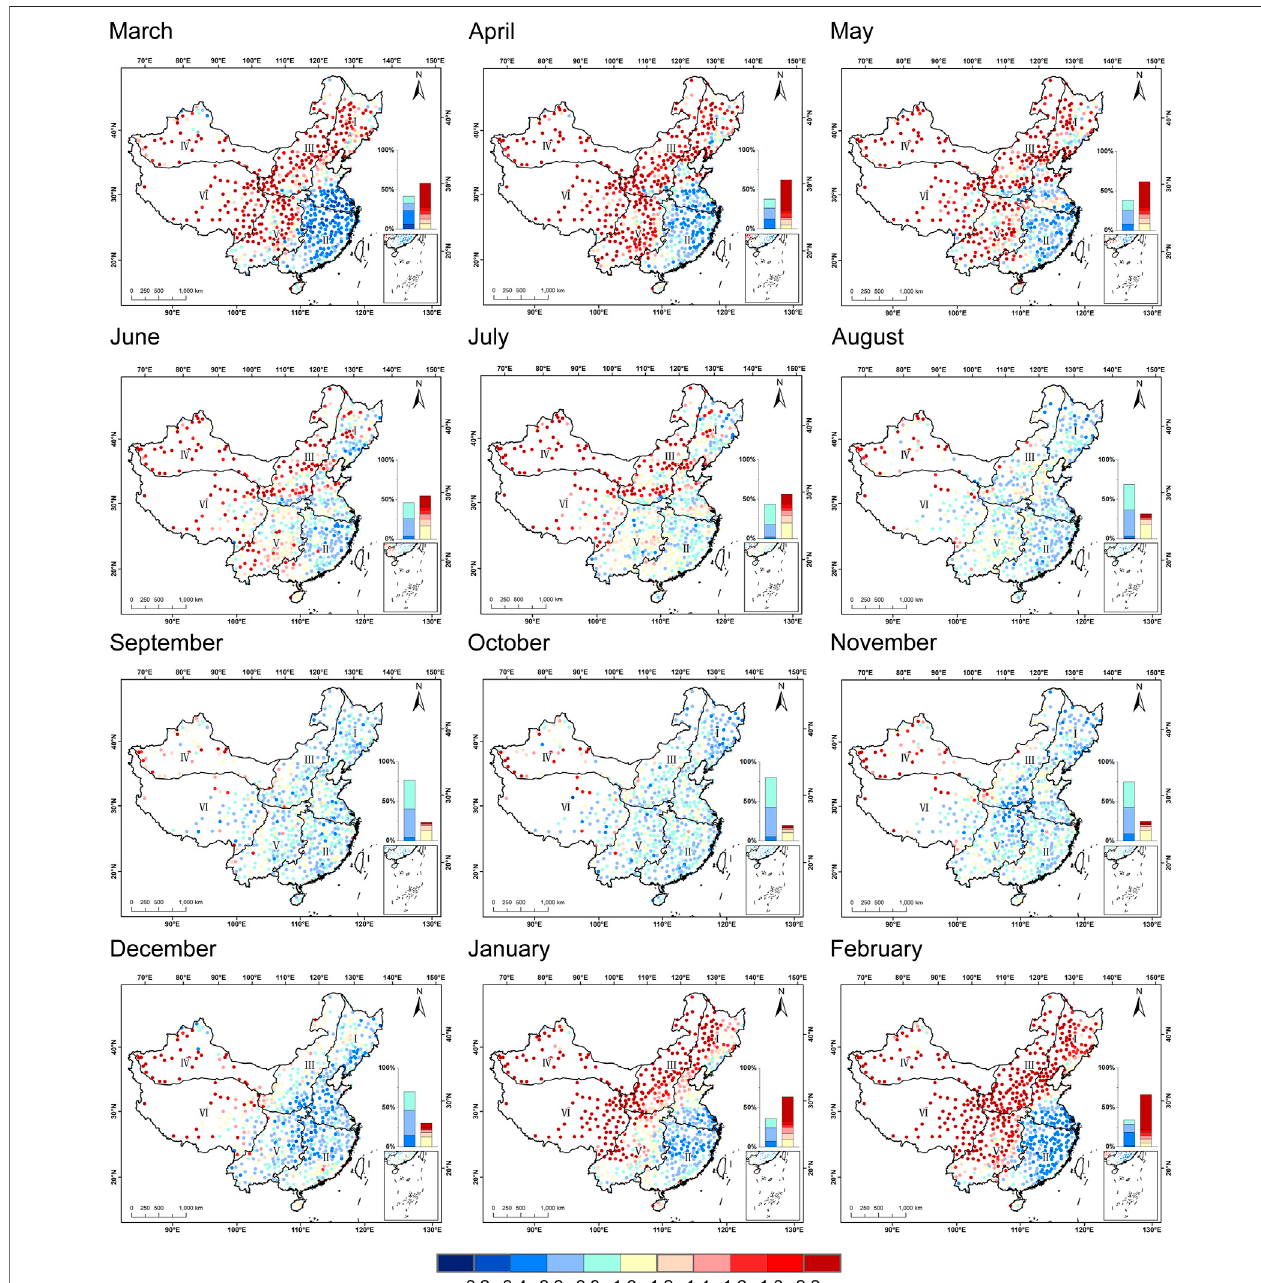
FIGURE 7 | Spatial distribution of DISO for RX5day of ERA5 over China from spring to winter. spring (March, April, and May), summer (June, July, and August), autumn (September, October, November), winter (December, January, and February).